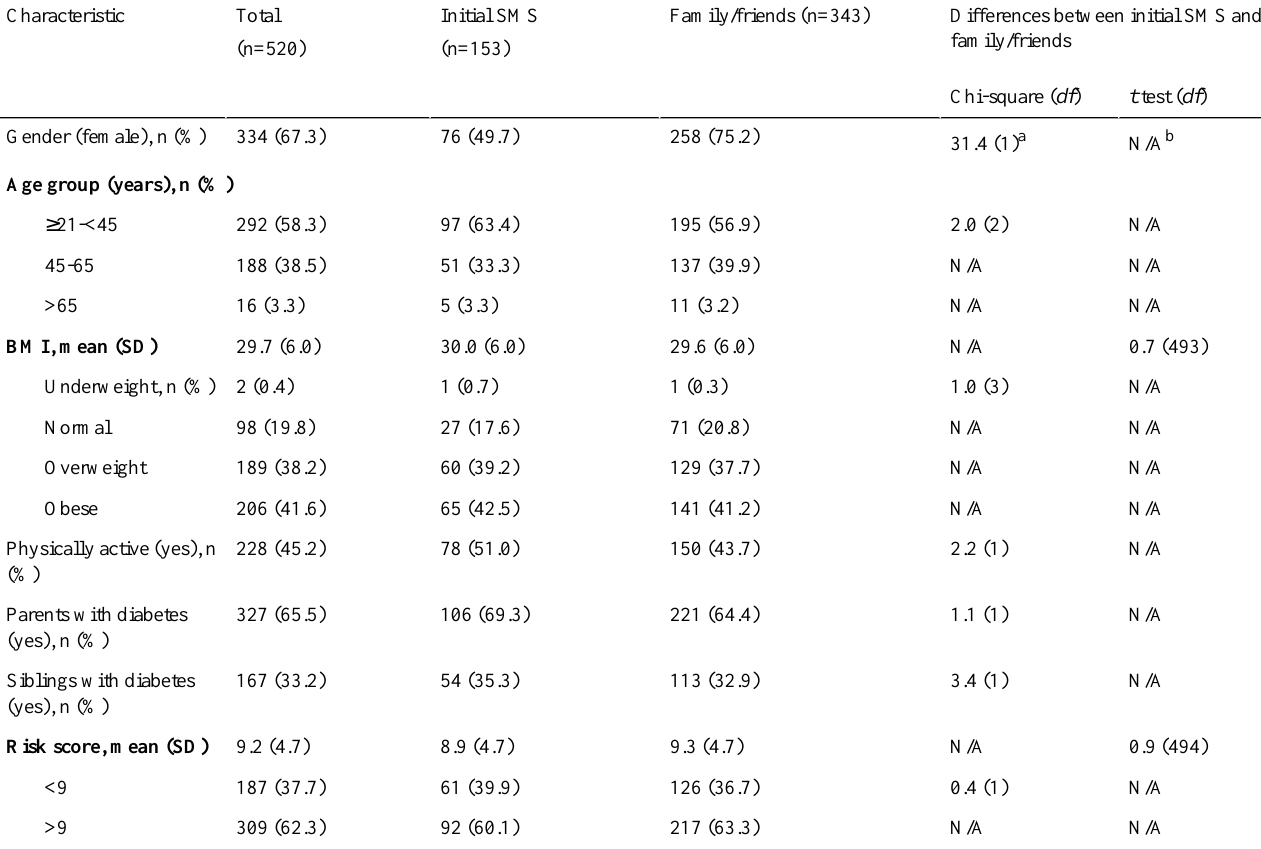
Table 2. Characteristics of individuals who responded to SMS campaigns (n=520), and differences among those who responded to the initial SMS and completed the survey (n=153) and those who were forwarded the SMS from family and friends and completed the survey